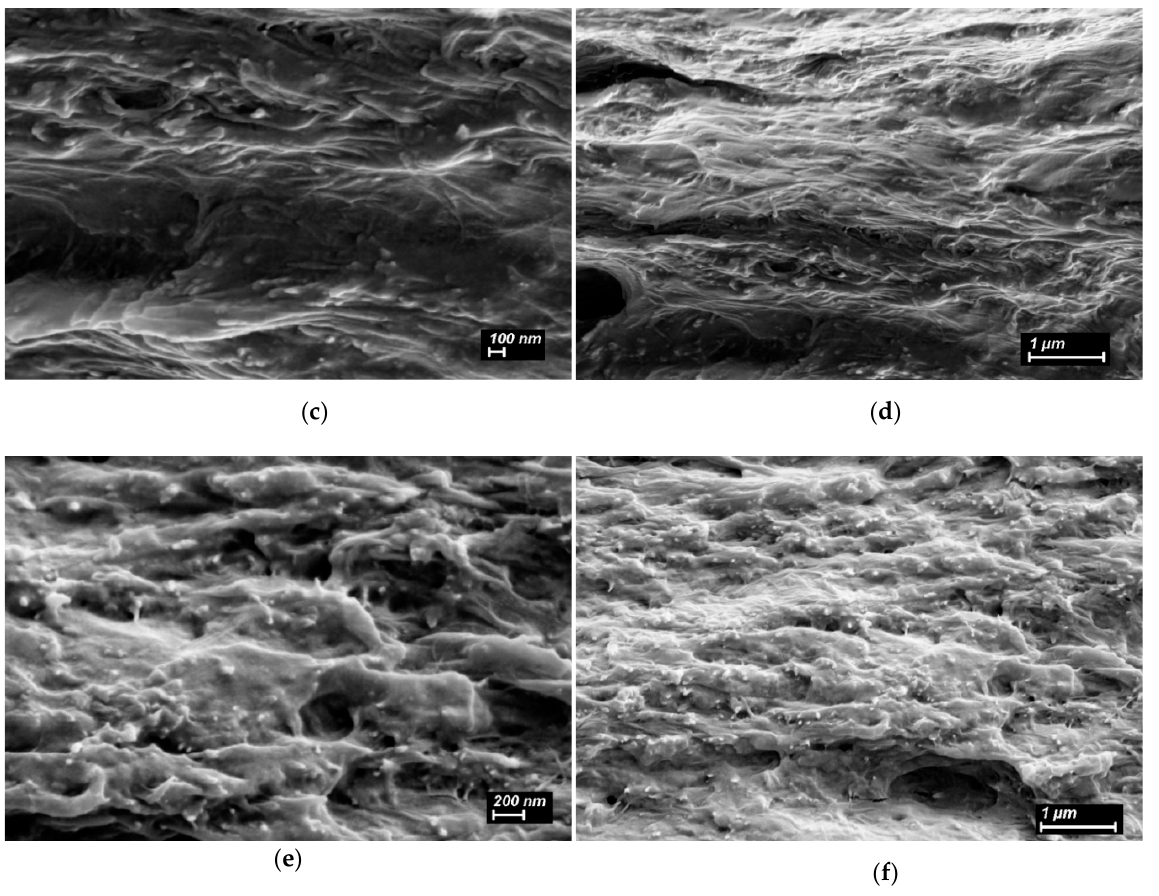
Figure 7. SEM images of cryocleaved surfaces of the CS film ( a ), dried dispersion of BCd ( b ), the CS(80)-BC(20) ( c , d ) and CS(80)-BCd(20)-CeONP(8) ( e , f ) films.